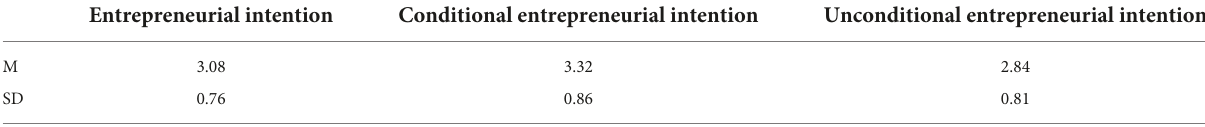
TABLE 1 Descriptive statistics of college students’ entrepreneurial intentions and its dimensions.